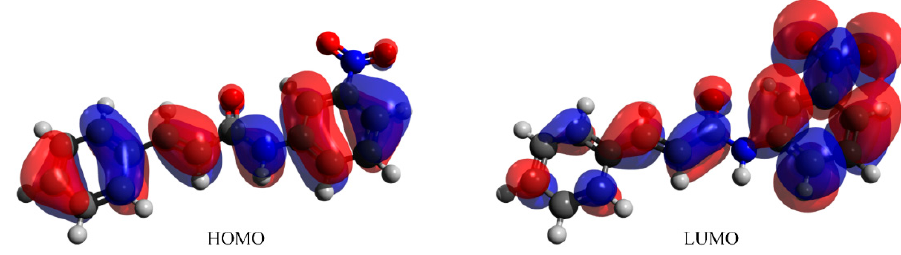
Figure 8. Frontier orbitals computed using the B3LYP functional and the 6-311 ++ G(d,p) basis set.